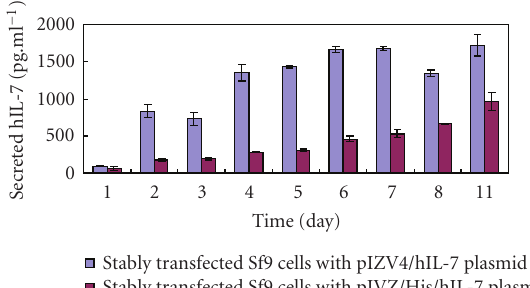
Figure 5: Production profile of hIL-7 in stably transfected Sf9 with two di ff erent expressions, cells were grown in serum-free medium (Sf900-II) in shaker flasks. The amount of hIL-7 in supernatants was measured by sandwich ELISA using rabbit antihuman IL-7 antibody as the capture antibody and a monoclonal antihuman IL-7 as the detection antibody. Streptavidin-horseradish peroxidase was used for conversion of a substrate mixture containing stabilized hydrogen peroxide, and stabilized tetramethylbenzidine commer- cially available as purified human IL-7 was used as a standard ( n =